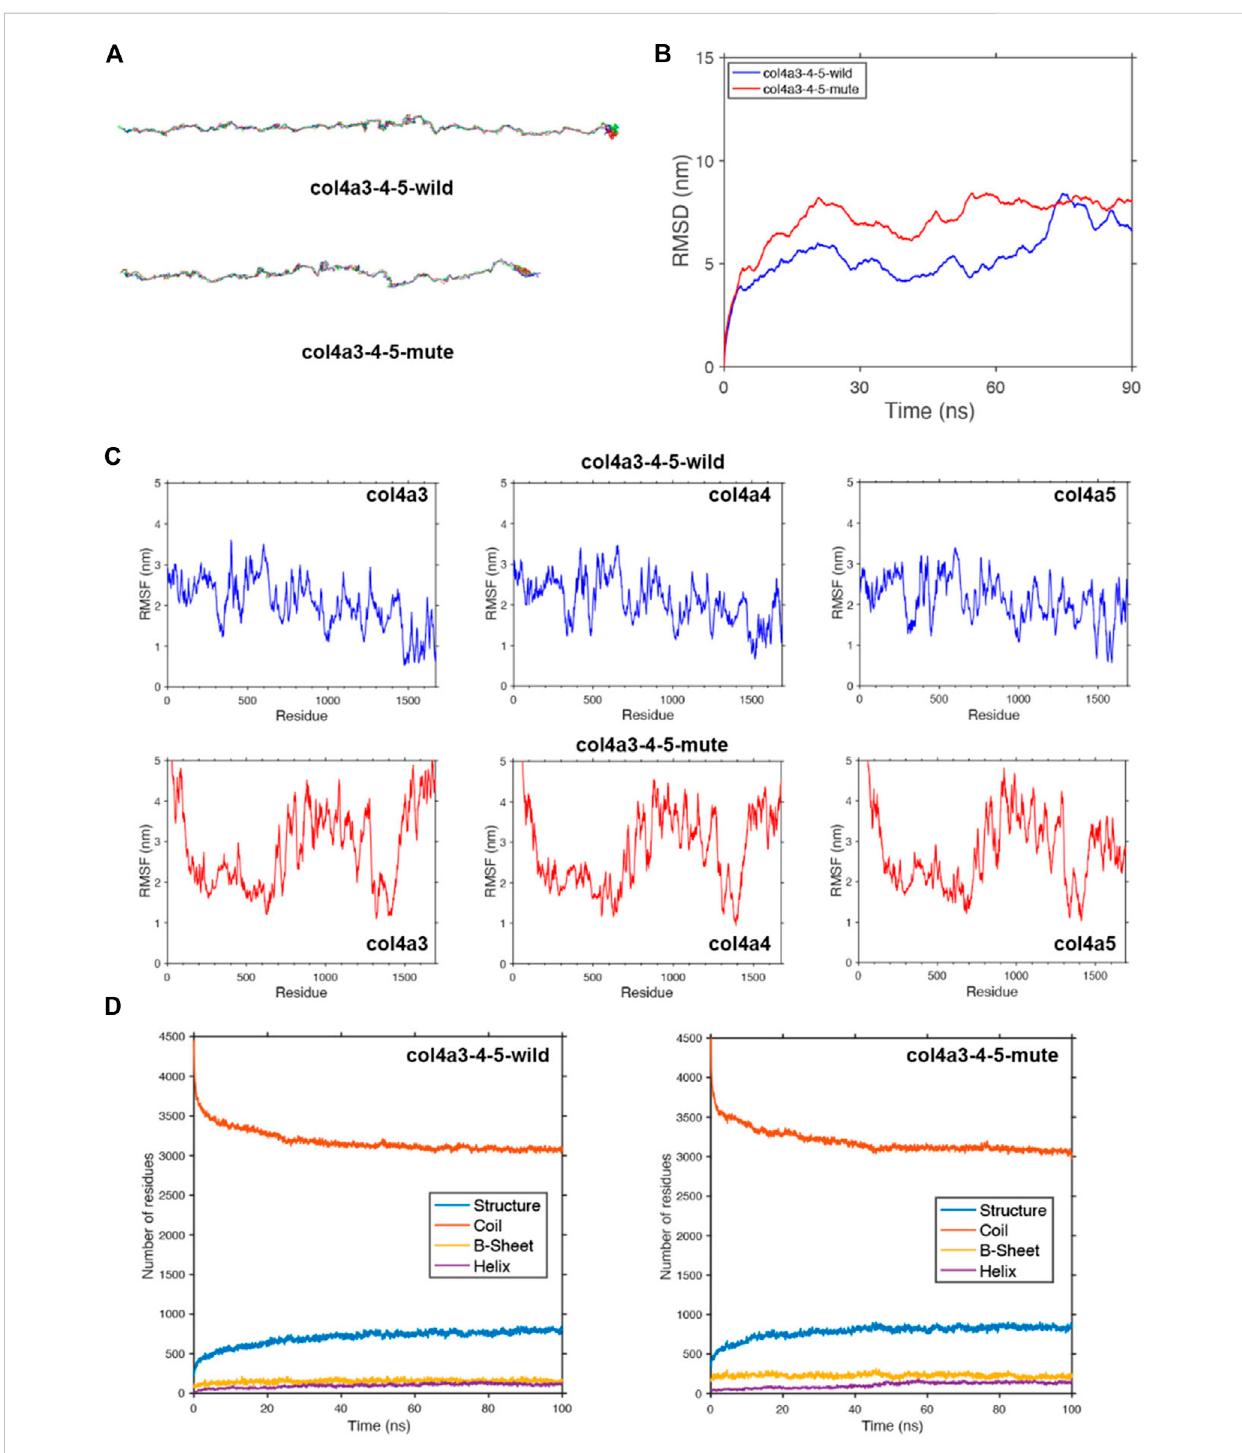
FIGURE 6 Protein moleculardynamics simulation of the α 345(IV) trimer. (A) The conformation ofthe α 345(IV)-wild and -mute triplechains throughmolecular dynamics simulations at 90 ns. (B) MSD of α 345(IV)-wild and -mute chains during 90 ns. (C) RMSF of each amino acid of the α 345(IV)-wild and -mute chains from 80 ns to 90 ns. (D) The numbers of the secondary structures of the α 345(IV)-wild and -mute chains during 100